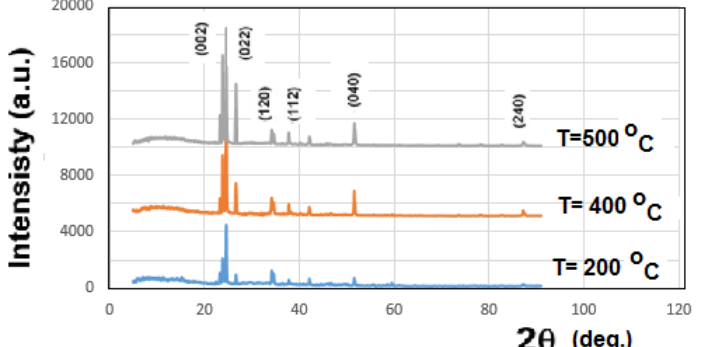
Fig. 2. XRD patterns of WO samples at T= (200, 400 and 500 °C) annealing 3